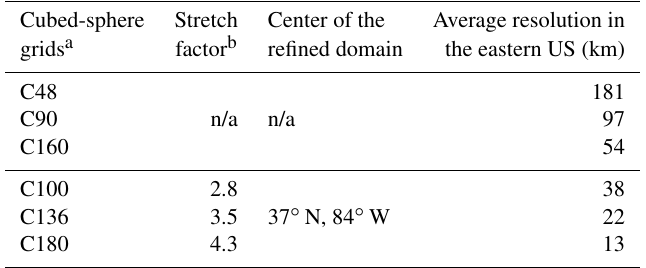
Table 1. Description of the simulations with six resolutions over the eastern US.